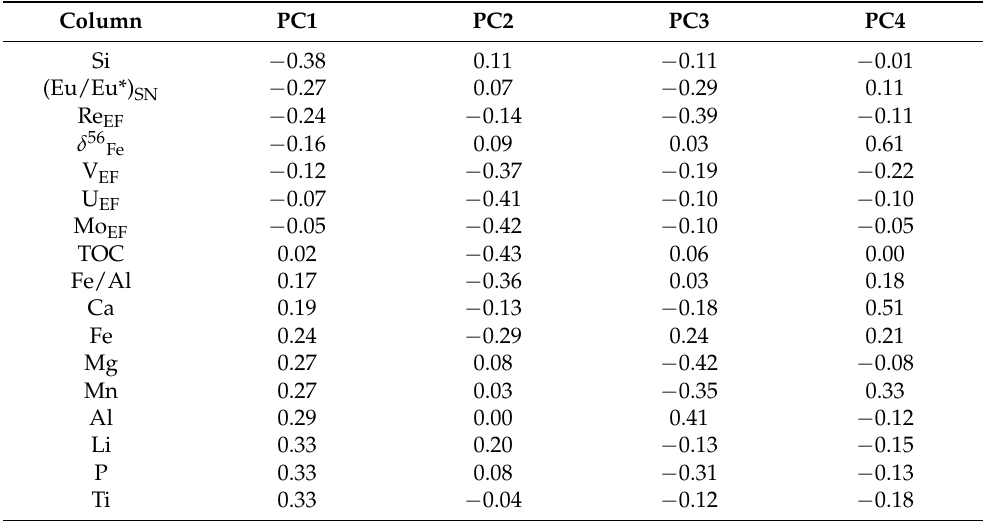
Table 1. Loadings placed on variables by the first four principal components (PC). See text for details on